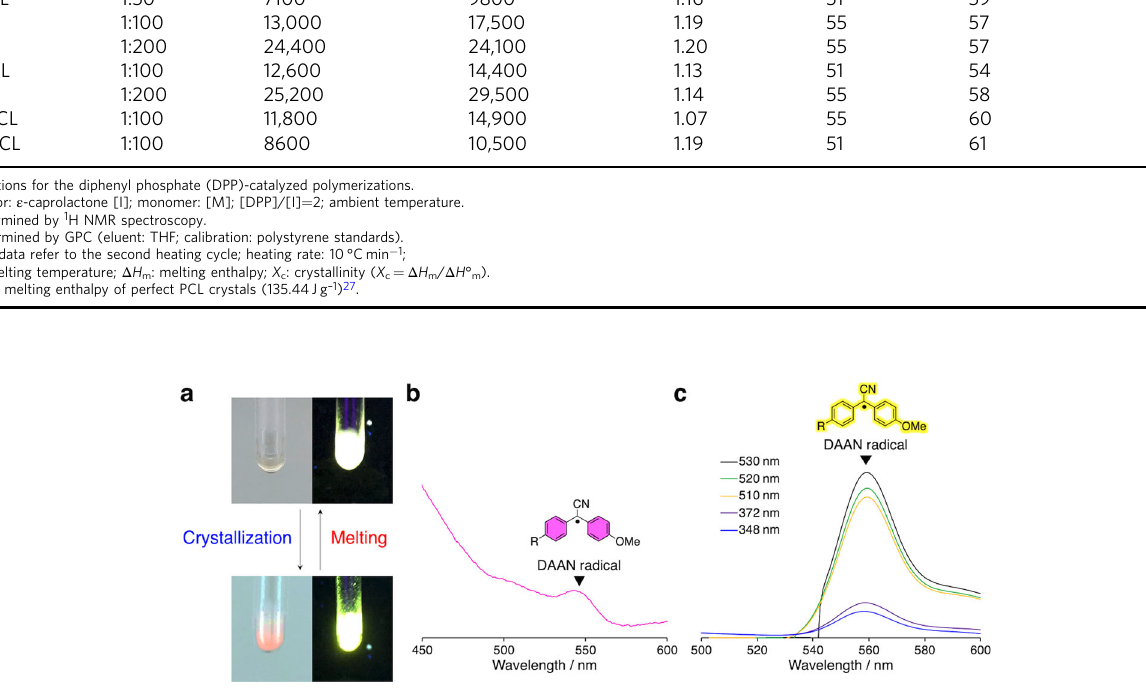
Fig. 2 CIMF during isothermal crystallization. a CIMF of L-PCL ( M n,NMR = 13000), which contains a TASN moiety at the center of the main chain. b Solid- state UV-vis spectrum of L-PCL ( M n,NMR = 13,000) after isothermal crystallization. c Solid-state fl uorescence spectra of L-PCL ( M n,NMR = 13,000) after isothermal crystallization under different excitation wavelength. (DAAN radical: diarylacetonitrile radical derived from TASN). NATURE COMMUNICATIONS| (2021) 12:126